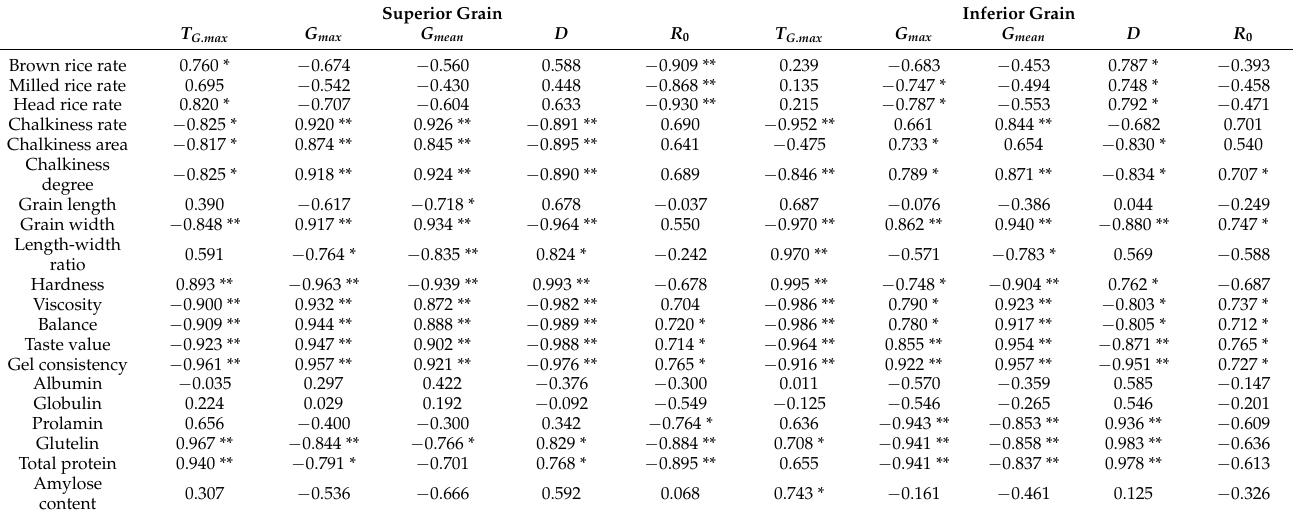
Table 7. Correlation of rice grain-filling parameters with grain